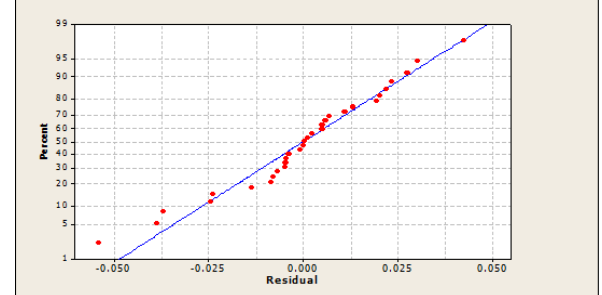
Table 6: Results of ANOVA.